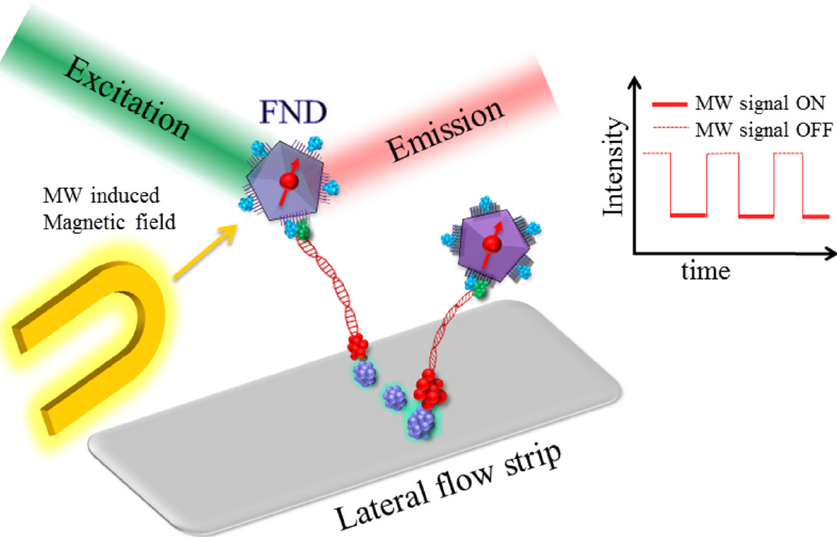
Figure 6. Schematic of the principle of HIV-1 RNA detection using FNDs and RT-RPA on the LFA. Labeled amplicons were generated during the reaction between Digoxigenin (DIG) and biotin-modified primers. The DNA primer binds with the HIV-1 virus RNA which is extracted from the patient. The primer then binds with c-DNA followed by purification and amplification. The labeled amplicons specifically bind with the functionalized nanodiamonds (FND-anti-DIG)) and streptavidin (purple) being immobilized on the lateral flow test strip. The NV center luminescence is recorded by applying microwave (MW) pulsed sequences in ON and OFF states.